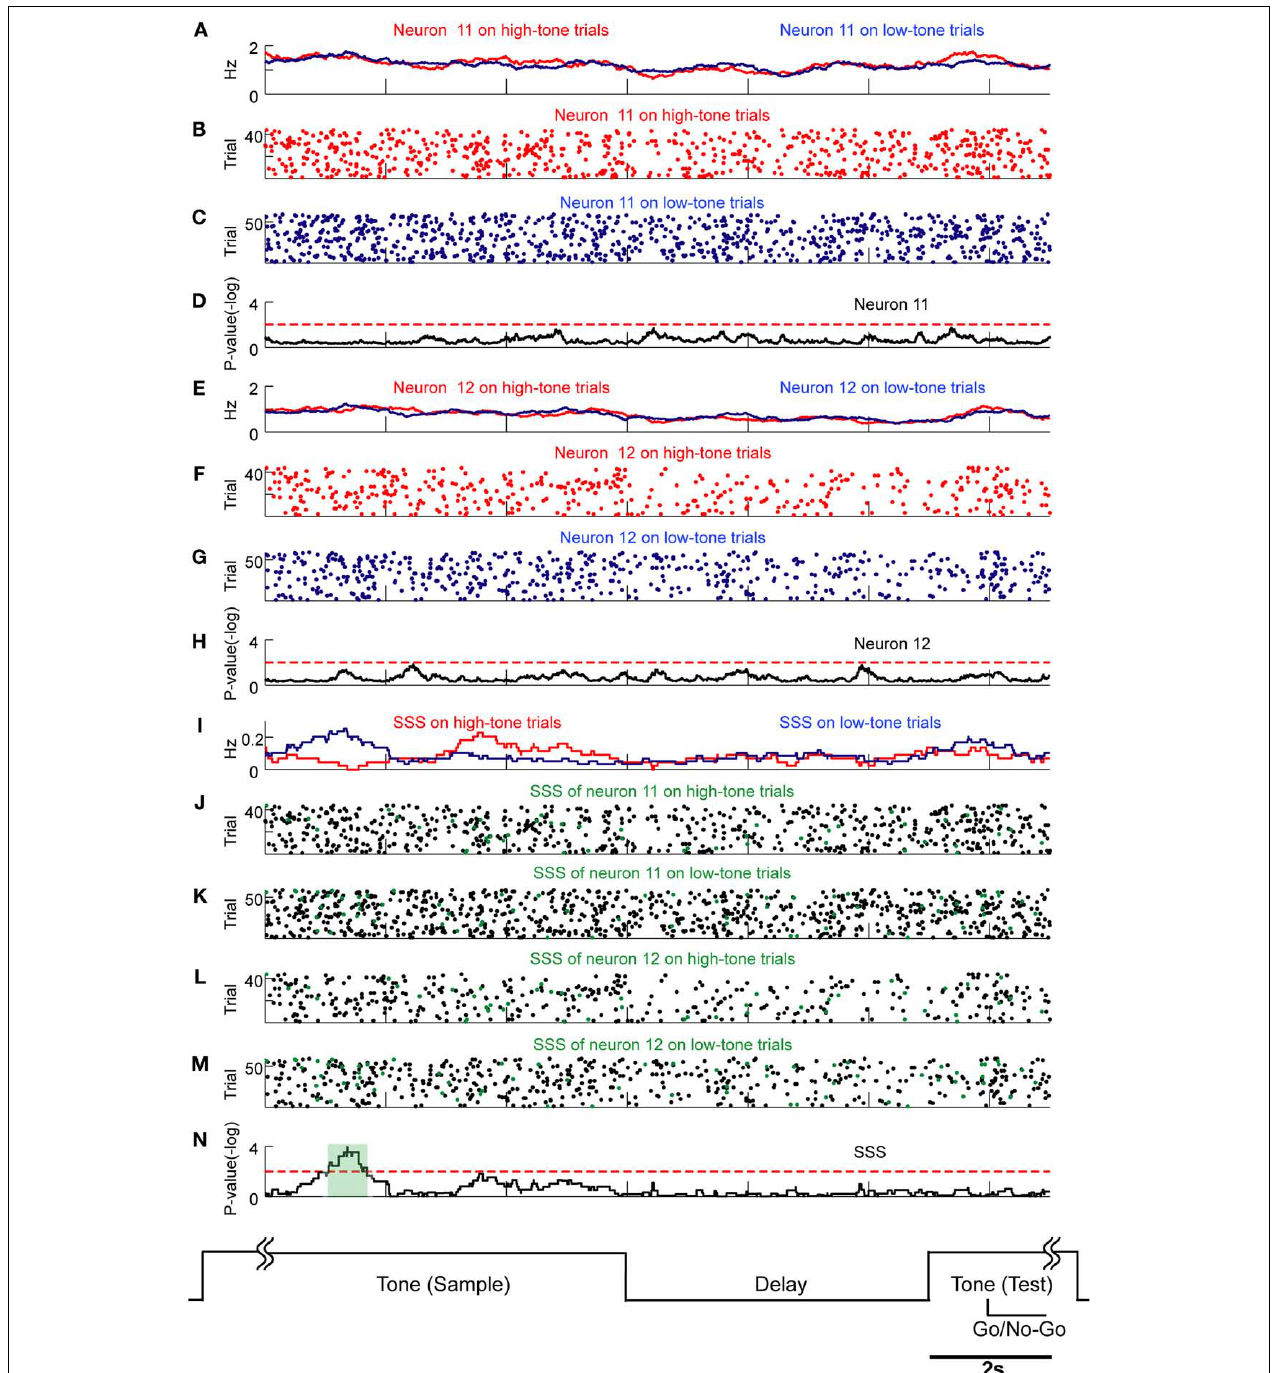
FIGURE 10 | SSSs related to stimulus inputs are not associated with fi ring rate modulations. Comparison of SSSs and rate modulations between high tone (red) and low tone (blue) trials was selected in this example. Results of U -tests of 6 s of tone presentation in the preceding trial, 5 s of delay, and 2 s of tone presentation in the next trial are shown. (A) Firing rates of neuron 11 in high tone (red) and low tone (blue) trials. (B,C) Raster plots of spikes of neuron 11 in high tone (red) and low tone (blue) trials. (D) P -values of neuron 11 for a